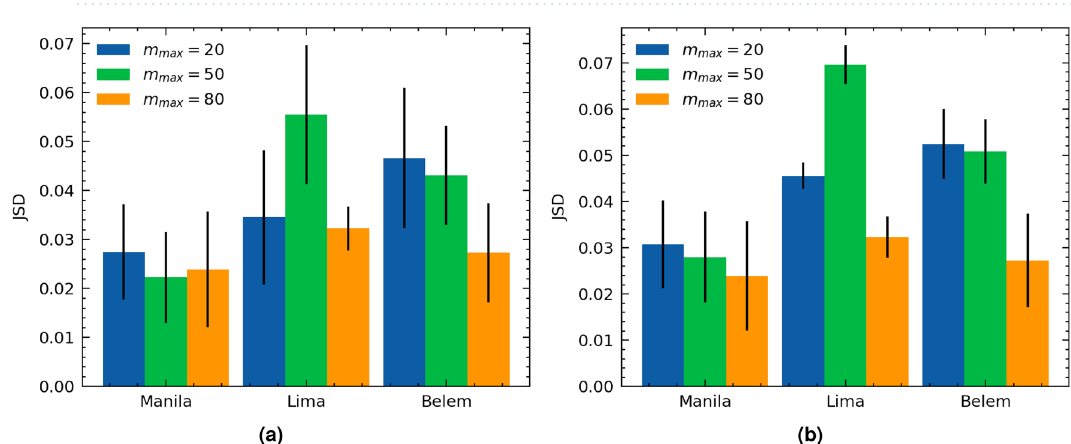
Figure 2. The average and standard deviation of JSD ( ˆ q ( m , | 0 � ) , q ′ ( m , | 0 � )) ; ( a ) over all depths m ∈ [ m max + 1, 100 ] and ( b ) over depths m ∈ [ 80, 100 ] while varying the maximum training depth m max on different IBM Q 5-qubit quantum